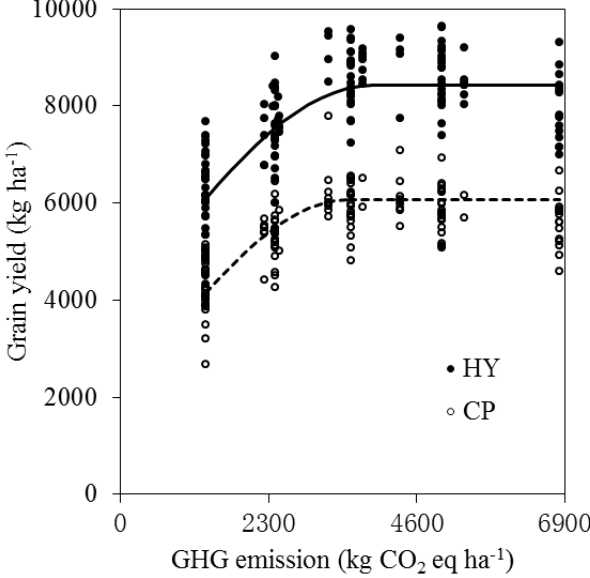
Fig. 1. The relationship between GHG emissions and grain yield for the CP (small circle and dashed line) and the HY (dot and solid line) system. Data were pooled from 33 sites of on-farm experiments for CP and HY systems. The relationship between GHG emissions and grain yield was Y = 1940 + 4137 ( 3 X/ 7110 − 0 . 5 (X/ 3555 ) 3 ), X < 3555; Y = 6077, X > 3555 ( R 2 = 0 . 75, P < 0 . 001) for CP system, and Y = 3845 + 4583 ( 3 X/ 7810 − 0 . 5 (X/ 3905 ) 3 ), X < 3905; Y = 8429, X > 3905 ( R 2 = 0 . 68, P < 0 . 001) for HY system. 284 kg N ha − 1 total N rate used under current practices.